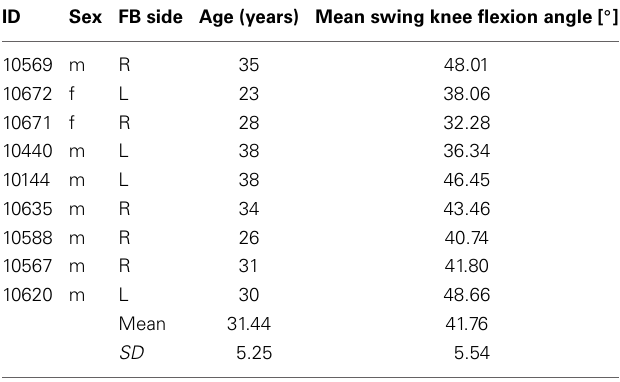
Table 1 | Data of non-impaired individuals participating in the pilot